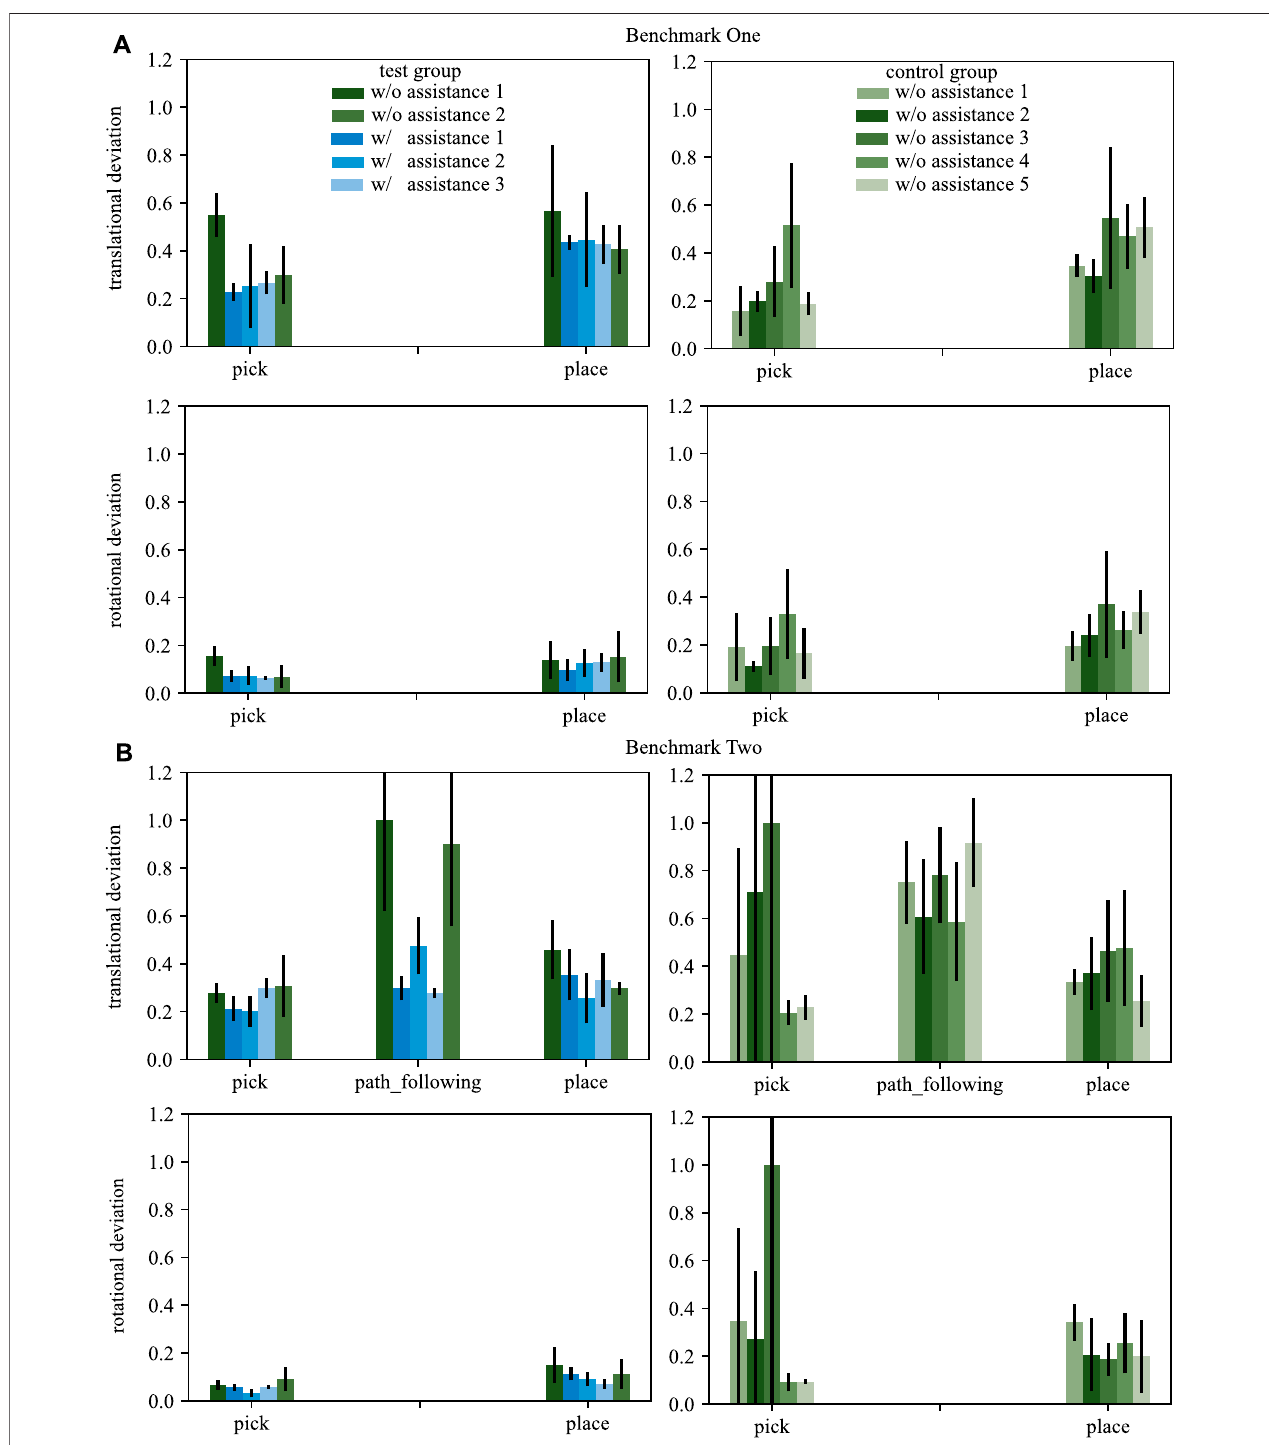
FIGURE 6 | The translational and rotational deviations for benchmarks one (A) and two (B) are shown. The left column depicts results of the test group, the right column of the control group. Blue bars display trials with assistance, green ones trials without assistance. The standard deviation is depicted by black arrows.